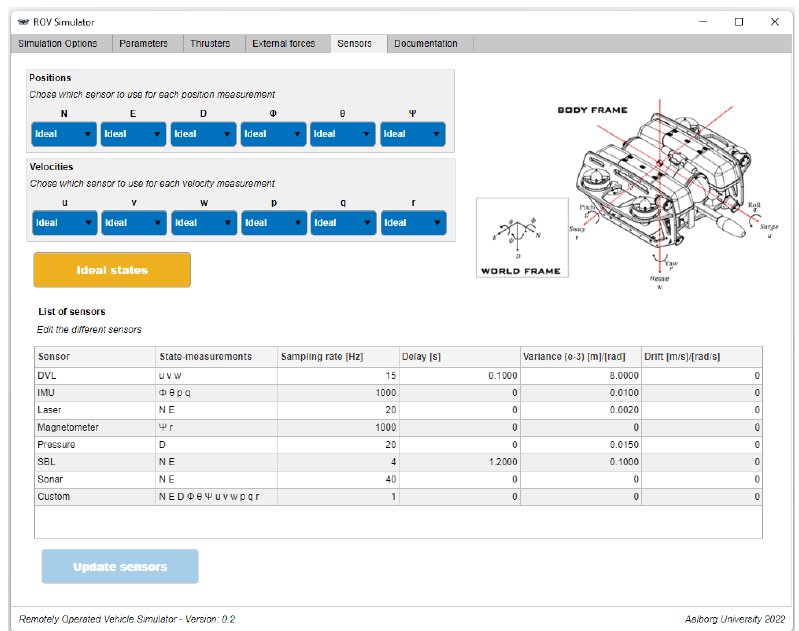
Figure A6. Overview of the Sensor disturbances pane within the ROV simulator app.